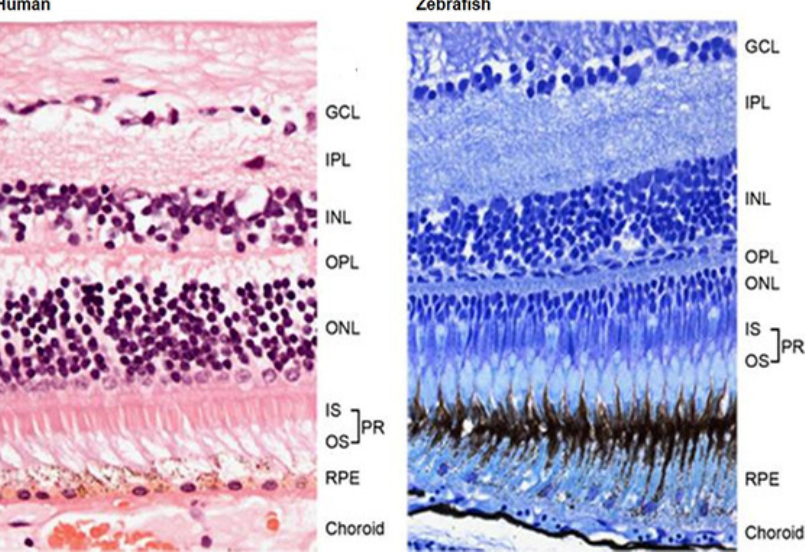
Figure 1. Cross-sectional view of the human and zebrafish retina indicating the similar structural features of the retinal layers [6]. features of the retinal layers